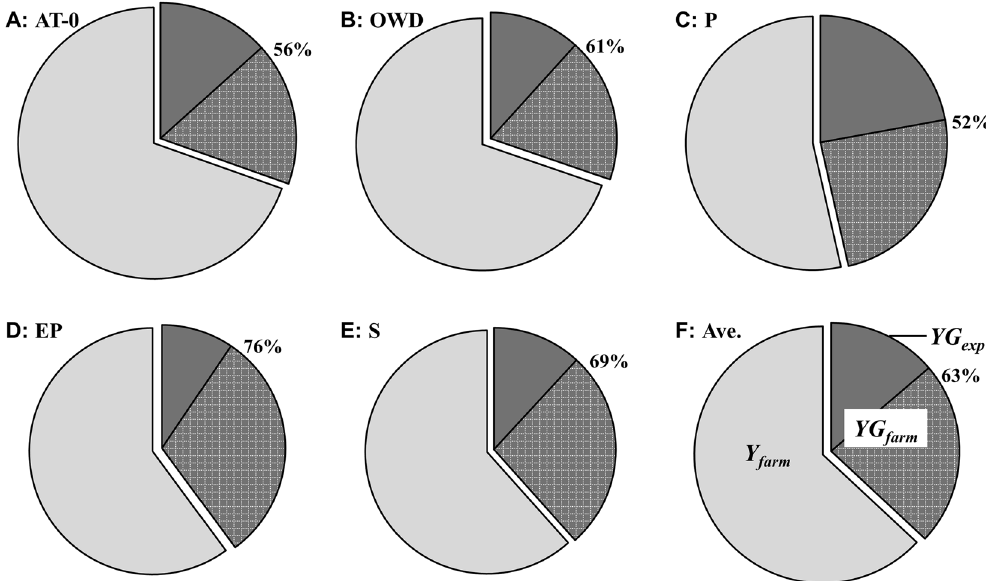
Figure 5. Yield gaps for different yield-limiting agroclimatic factors. ( A ) AT-0, ≥ 0 °C accumulated temperature; ( B ) OWD, overwintering days; ( C ) P, precipitation; ( D ) EP, precipitation at an earlier stage; ( E ) S, sunshine hours; ( F ) Ave., whole region. The size of pie chart represents the Y att , the pale gray part on the left represents the Y farm , the two dark gray parts on the right represent the YG farm , and the YG exp , and the percentage beside the pie chart represents the NYG exp